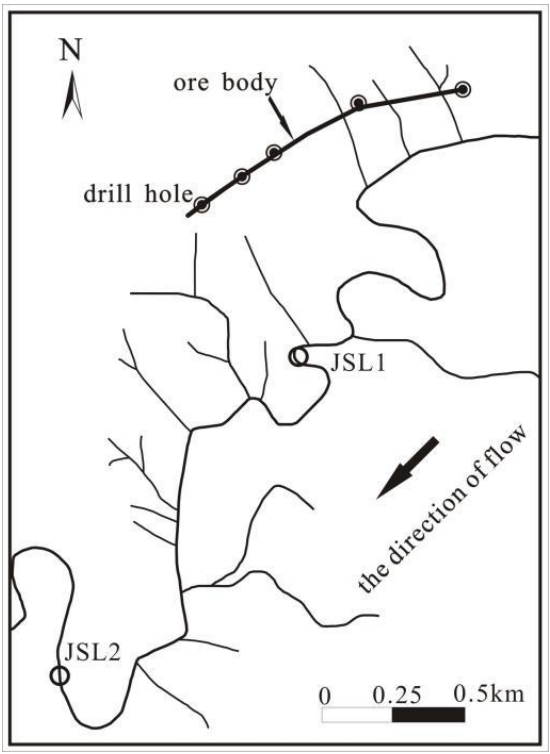
Figure 2. Location map of test samples.